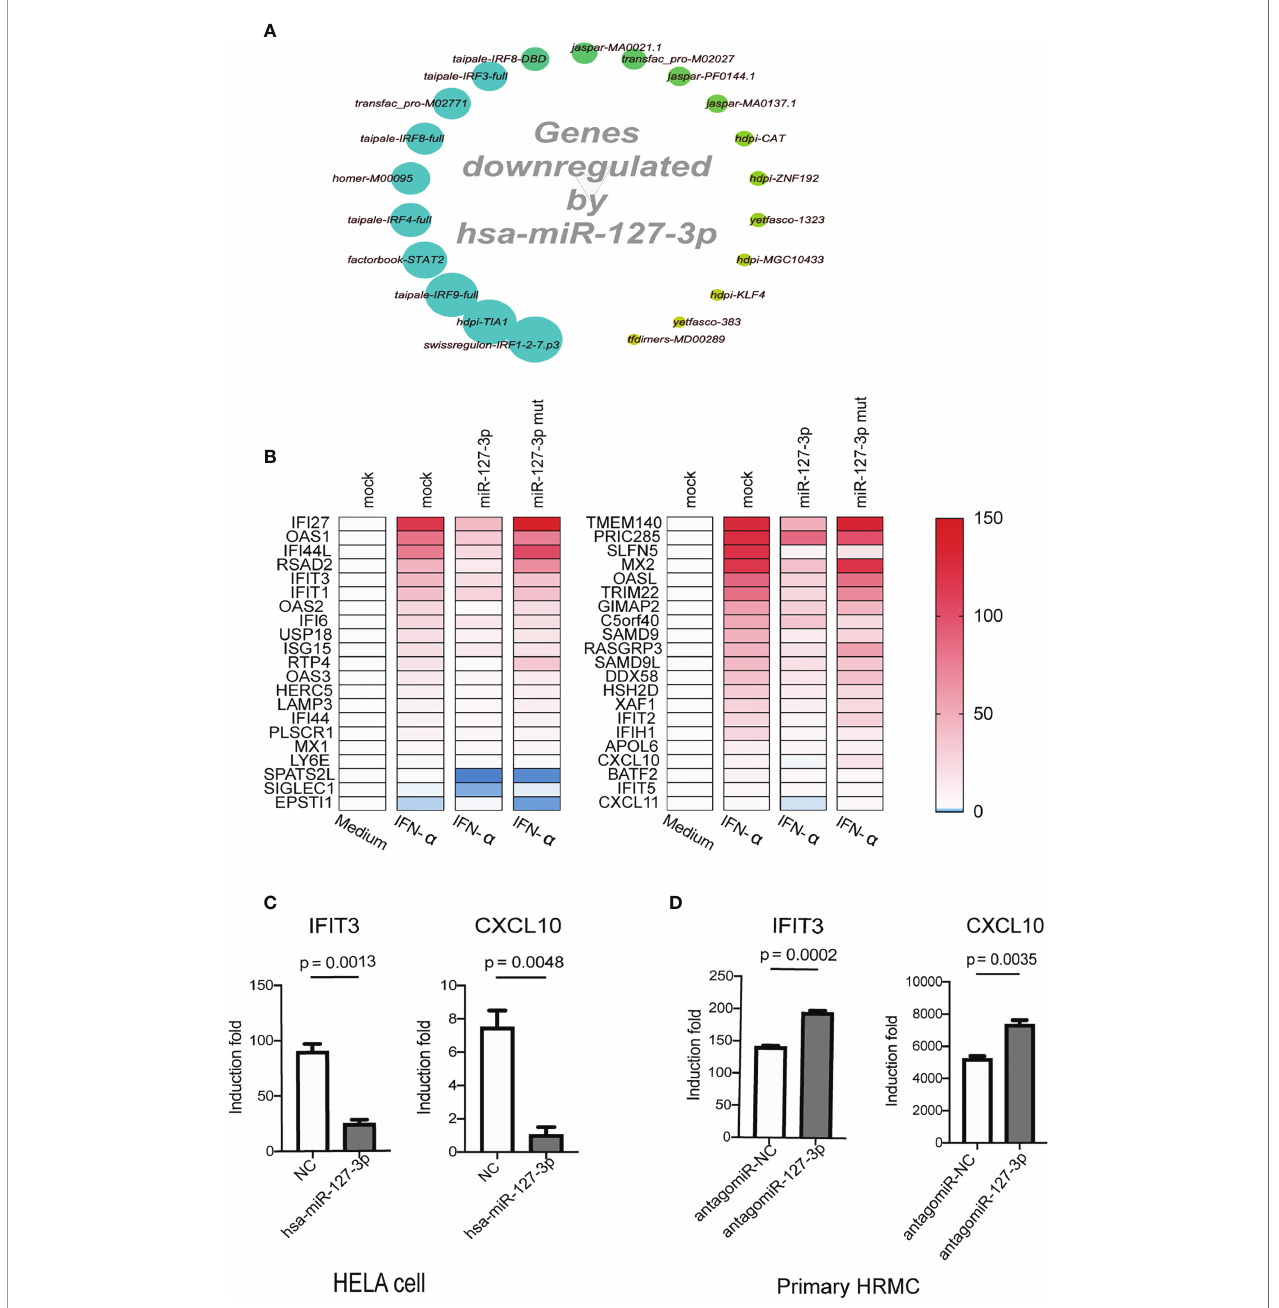
FIGURE 2 | Hsa-miR-127-3p inhibits the induction of IFN stimulated genes. (A) Hsa-miR-127-3p inhibited genes as compared with the controls (mock transfection, negative control mimics and hsa-miR-127-3p mutant mimics) in IFN- a treated Hela cells were used for the enrichment analysis of cis-regulatory motif using iRegulon plugin on Cytoscape platform. Big dots with deeper green color represent the motifs with higher normalized enrichment scores. (B) Heatmaps show the expression of the ISGs that constitute a 21-gene IFN signature (YAO score) (left) and additional top 21 IFN induced genes (right) in Hela cells that were transfected and stimulated as indicated in the pictures. Mock transfected Hela cells without IFN stimulation was used as baseline control. Red = upregulated; White = no change; Blue = downregulated. (C) qPCR analysis was performed for IFIT3 and CXCL10 in Hela cells transfected with negative control mimics (NC) or hsa-miR-127-3p mimics and stimulated with universal type I interferon for 8 h. (D) qPCR analysis was performed for IFIT3 and CXCL10 in primary HRMCs transfected with antagomiR-NC or antagomiR-127-3p and stimulated with universal type I interferon for 8 h. (C, D) The induction fold was calculated by dividing the relative expression of IFIT3 (or CXCL10) of a sample in experimental groups by the relative expression of IFIT3 (or CXCL10) of an unstimulated control sample. Data from at least 3 independent experiments are plotted and presented as mean±SEM. P values were determined by Mann-Whitney